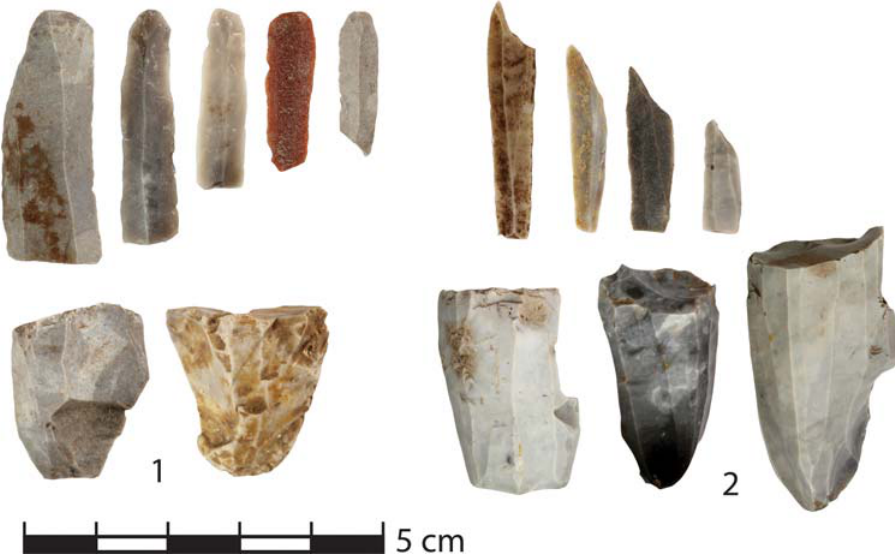
Figure 8: Typical fl int artefacts. 1. Cores and blades/microblades from Adal. 2: Cores and microliths from Løvås. Photo: